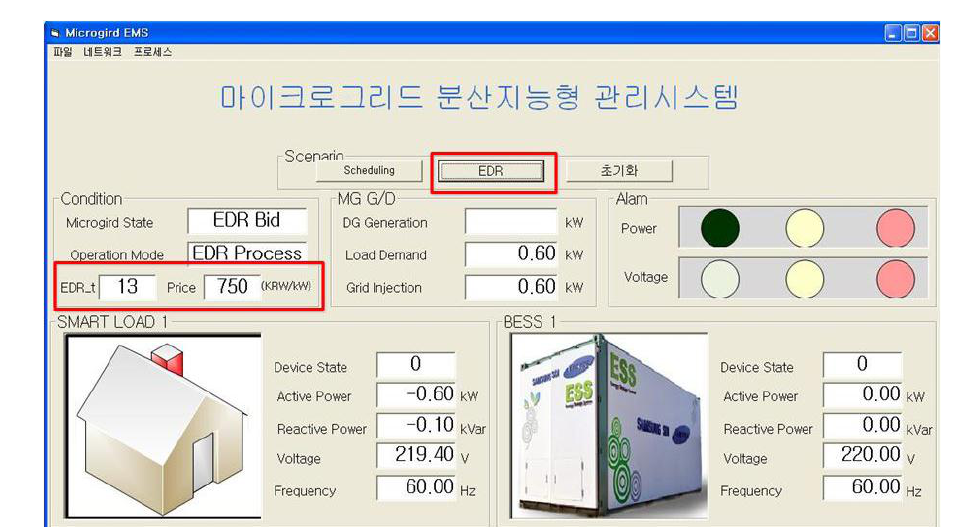
Figure 11. Emergency demand response (EDR) data input display in the MGCC program.